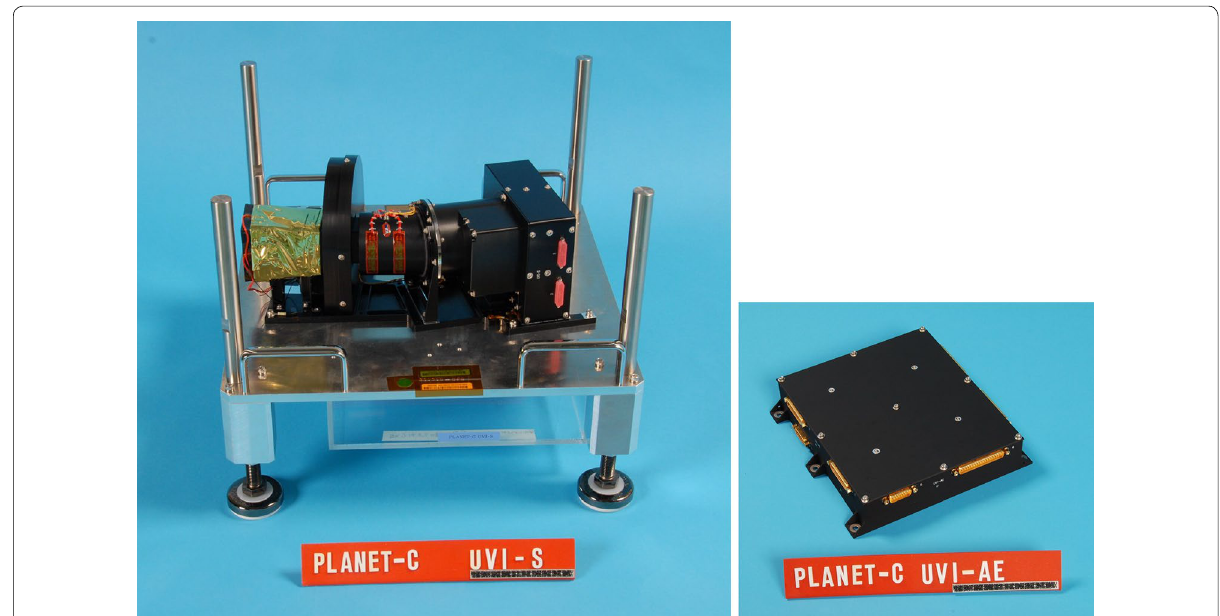
Fig. 1 Photographs of UVI‑S (left) and UVI‑AE (right). The radiator for the CCD cooling is hiding under the baseplate of the instrument in the left panel